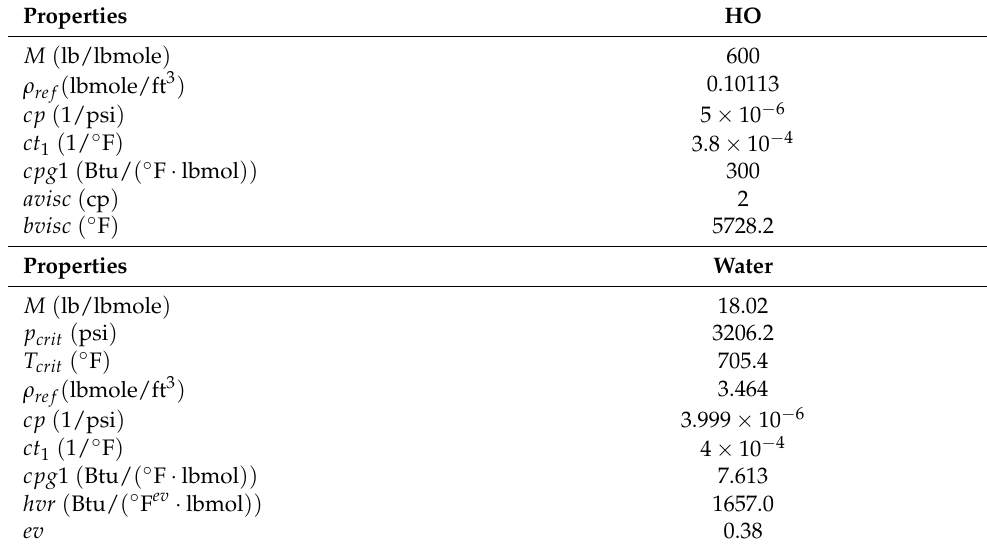
Table 3. Property data for Example